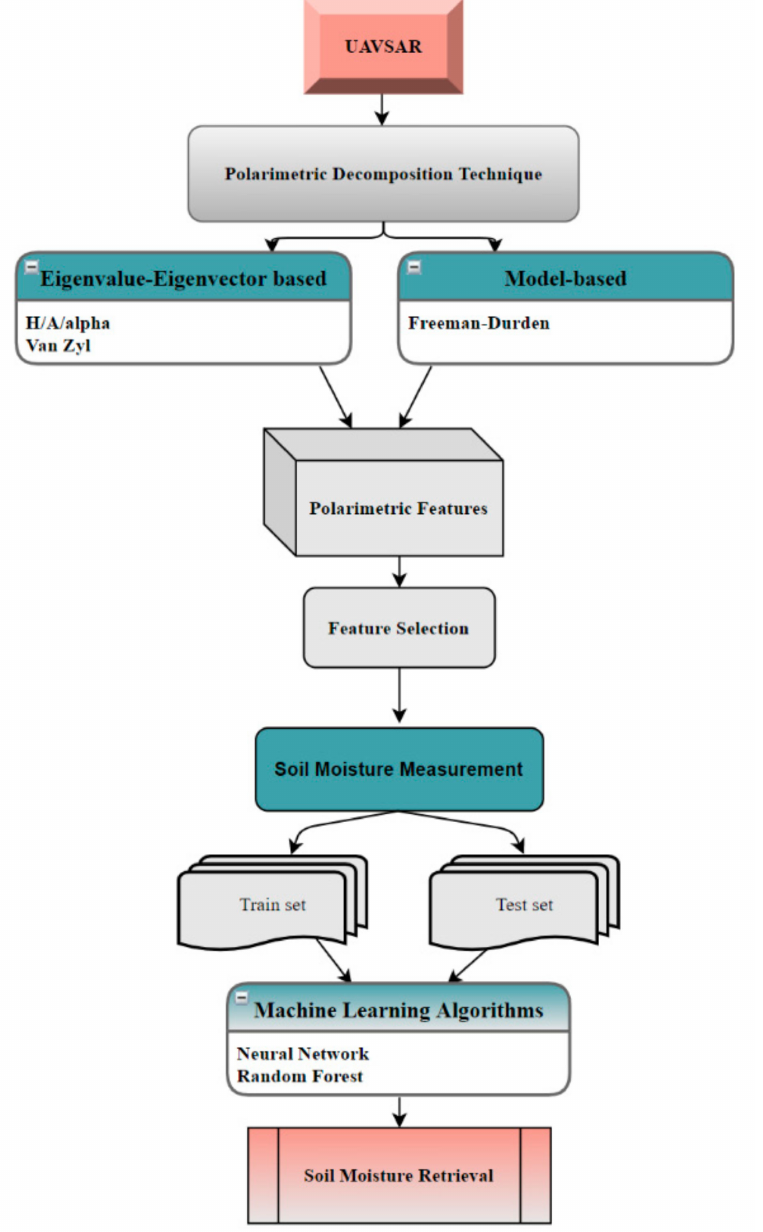
Figure 2. Workflow describing the application of Synthetic Aperture Radar (SAR) decompositions, polarimetric feature selection, selection of training and testing data, and application of machine learning algorithms for soil moisture